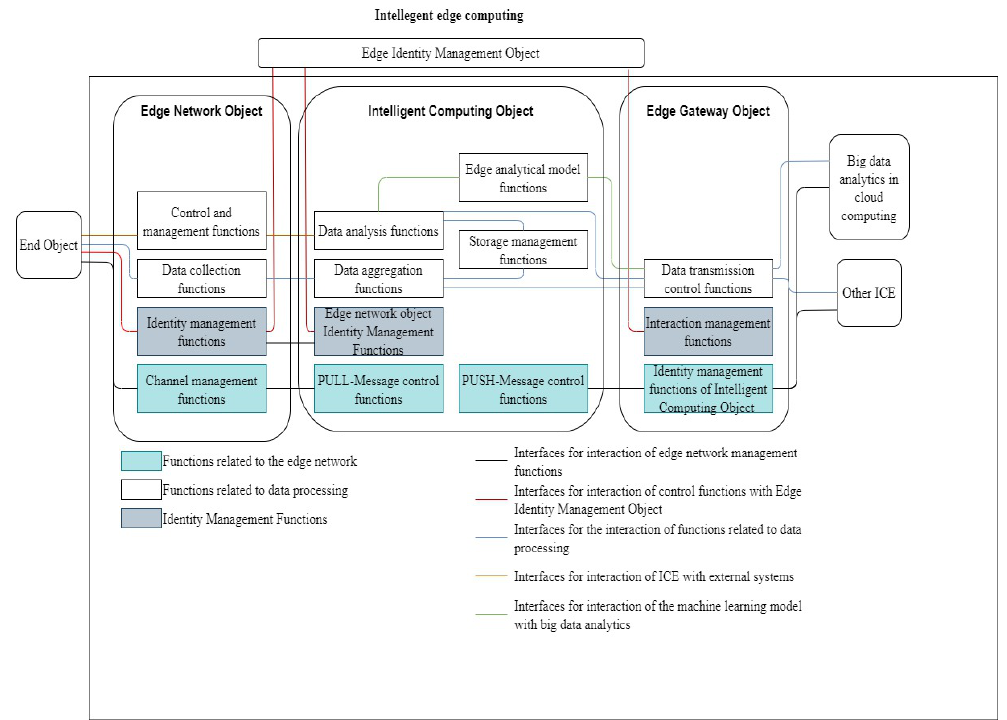
Figure 2. IEC Architecture